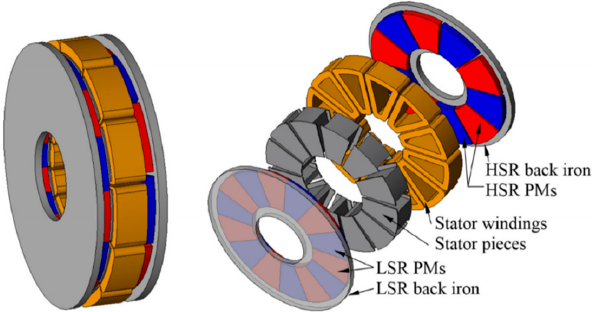
Figure 9. Configuration of an axial-flux magnetic-geared PM (MGPM) machine [24].